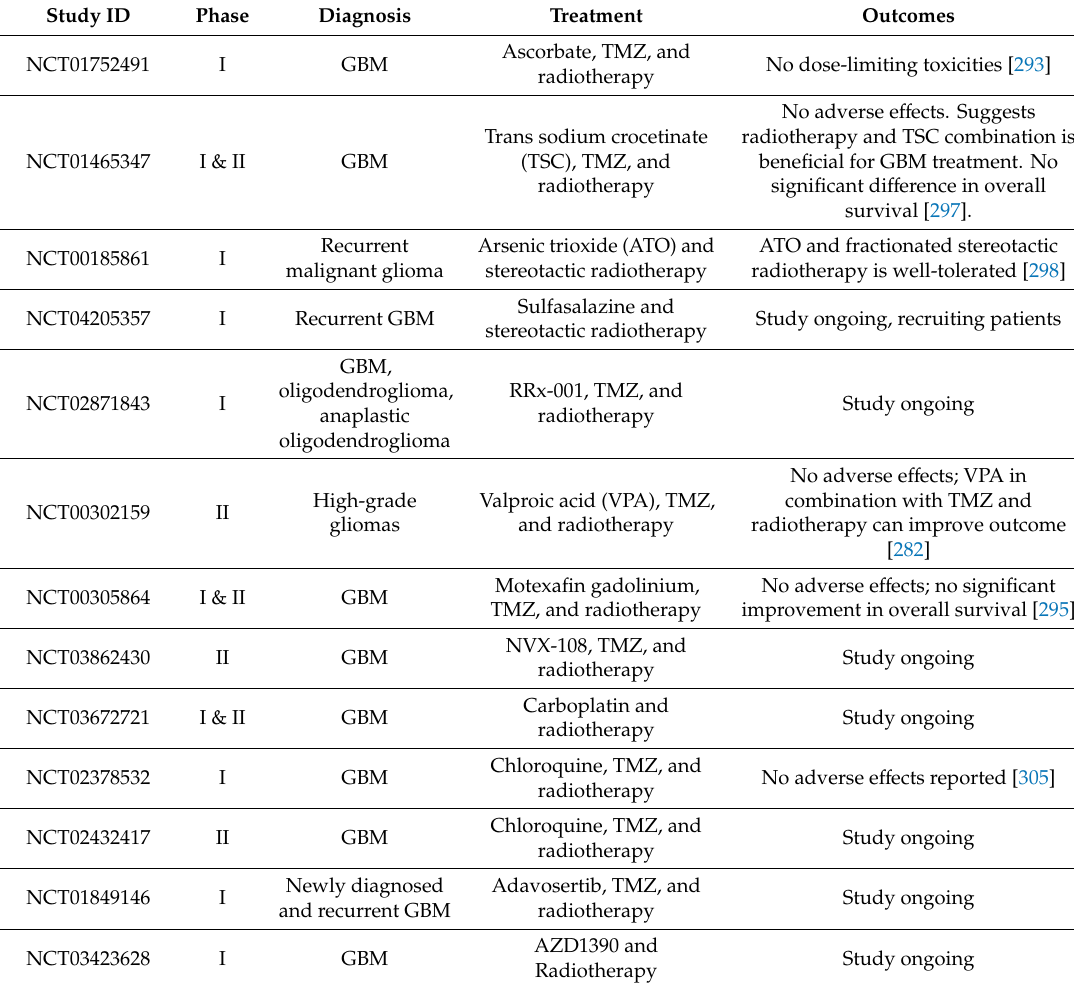
Table 2. List of current and previous clinical trials of radiosensitizers for GBM